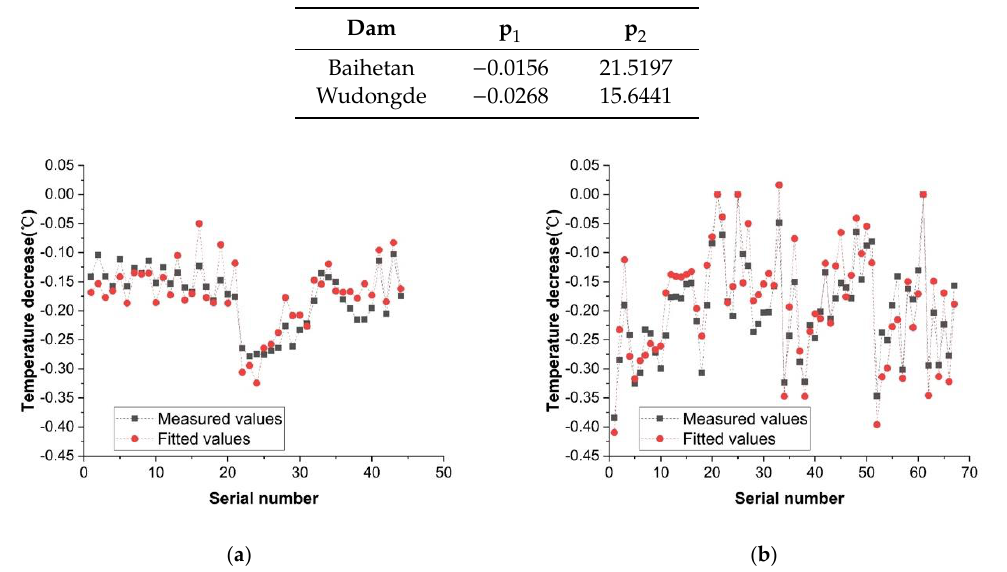
Table 3. Parameter values in Equation (1).